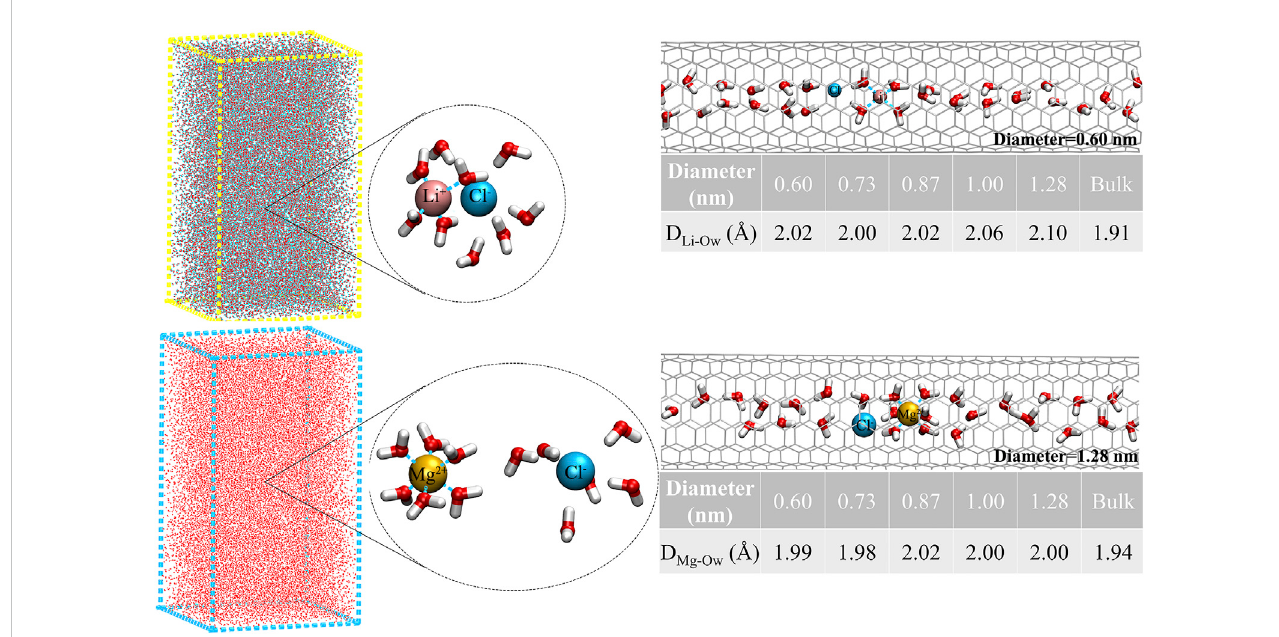
FIGURE 2 Hydration structure of ions and the average bond lengths of cations and water molecules, Li + and Cl − in the bulk solution, and the fi ve CNTs.